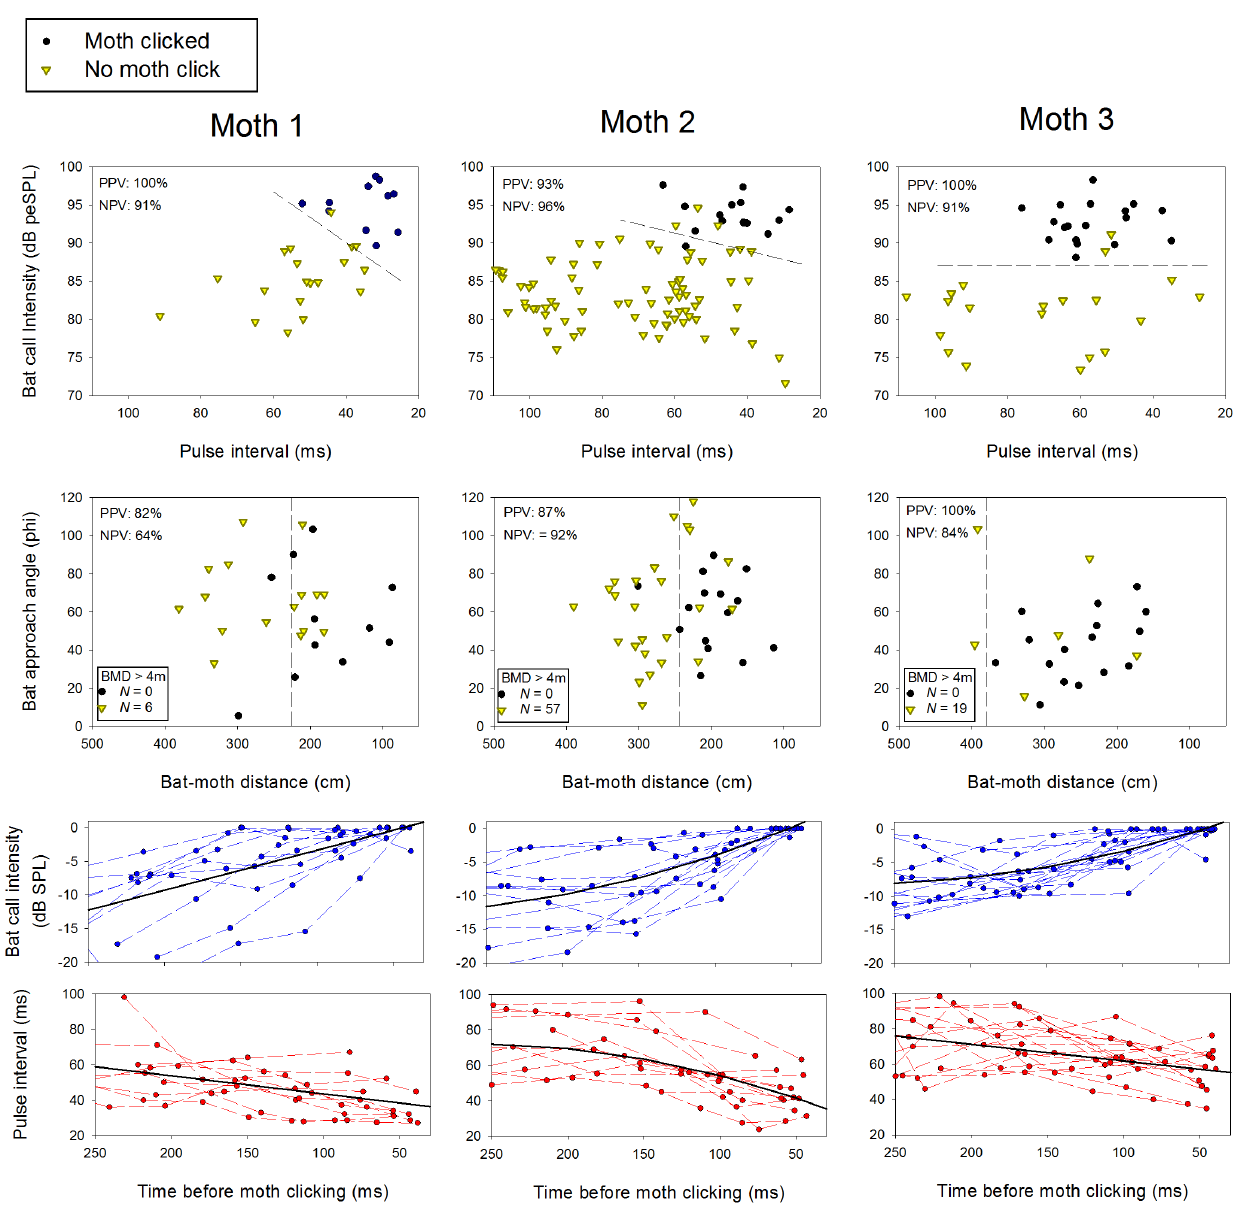
Figure 6. Discrimination of bat passes that did or did not elicit clicking by tethered B.trigona in the field. Acoustic characteristics (bat pulse interval vs . bat call intensity) and bat flight characteristics (distance from moth vs . flight trajectory relative to bat-moth vector, or phi) were used to differentiate bat passes that elicited a clicking response and those that did not (Top two rows of graphs). Dashed lines indicate thresholds for discriminating clicking from non-clicking interactions using discriminant function analysis. PPV, positive predictive value, or the percent of clicking interactions correctly classified; NPV, negative predictive value, or the percent of non-clicking interactions classified correctly. Some interactions were included where bats were outside the calibrated volume of the cameras and bat-moth distance (BMD) was . 4 m. Exact BMD and bat approach angles were not available for these interactions. Bat call intensities increased and pulse intervals decreased prior to moth clicking (bottom two rows of graphs; see Table 2 for